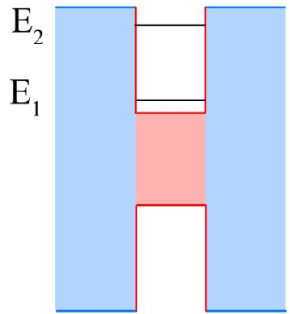
Figure 3. A band diagram of a quantum well in a QWIP. Carriers are excited by incident photons from the ground energy state of the well ( E well ( E 2